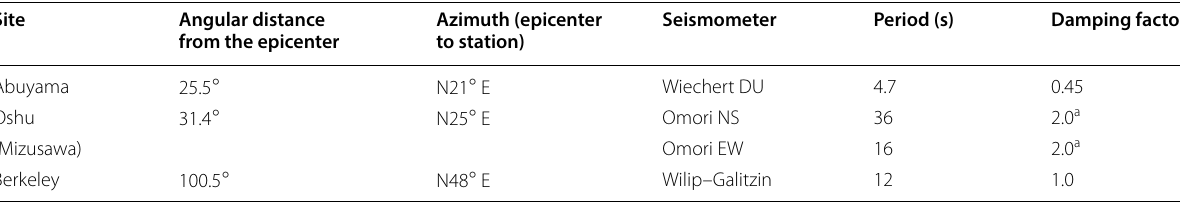
a Estimated by trials and